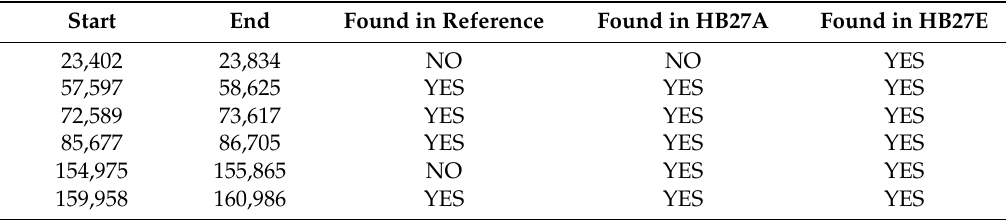
Table 4. Coordinates location of ISTth7 soft-clipped reads in the megaplasmid of the reference strain T. thermophilus HB27 (GenBank accession